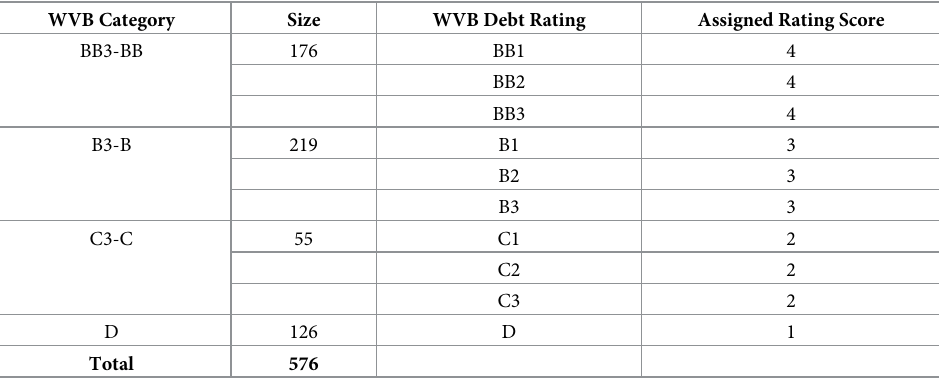
Table 1. The dataset